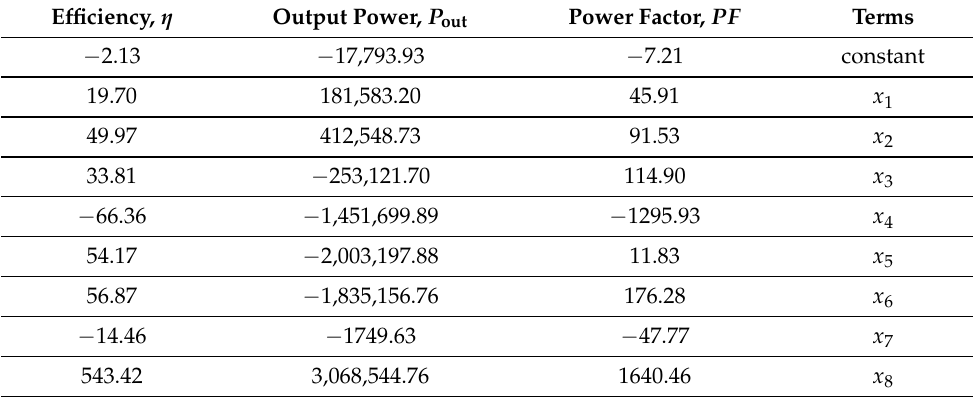
Table A1. Quadratic closed form equation of Box–Behnken design—constant and first order terms.